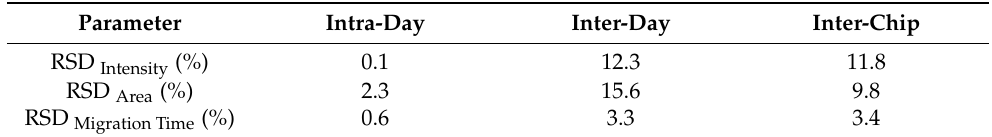
Table 1. Summary of intra-day, inter-day, and inter-chip comparisons for the analysis of a